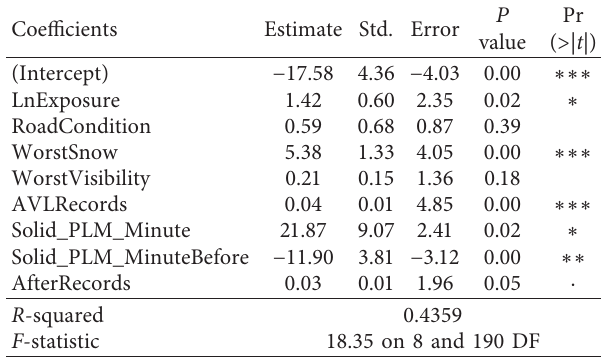
Table 6: Crash frequency